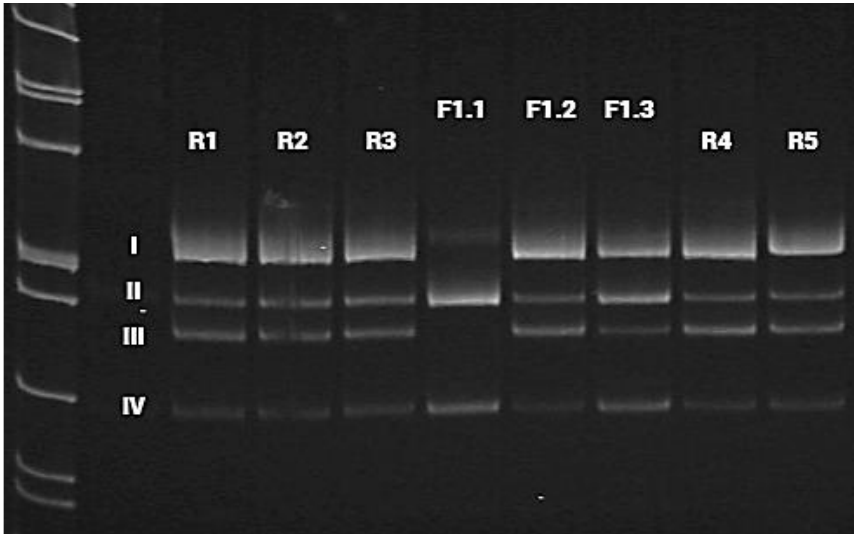
Figure 5. Visualization of cDNA amplification products for the proband (F1.1), his parents (F1.2 and F1.3), and reference samples (R1 – R5), with primers flanking introns 4 and 9 of the HACE1 gene. Band I (529 bp) includes the sequences of exons 5, 6, 7, 8, and 9 of the HACE1 gene, which corre- sponds to the canonical protein-coding transcript 1 (isoform a). This amplicon was absent in the proband (F1.1). Band II (446 bp) includes the sequences of exons 5, 6, 8, and 9 of the HACE1 gene without exon 7 (isoform d). Band III (397 bp) corresponds to protein isoforms b and e, whose tran- scripts do not contain the sequence of HACE1 exon 6, but contain exon 7. Band IV (314 bp) does not include the sequences of exons 6 and 7 of the HACE1 gene, which corresponds to the transcript of HACE1 isoform h. Bands I and III were not registered in the proband (F1.1). In the proband’s father (F1.3), we detected an increase in signal intensity for bands II and IV as compared to the reference samples (R1 – R5) and the maternal sample (F1.2).